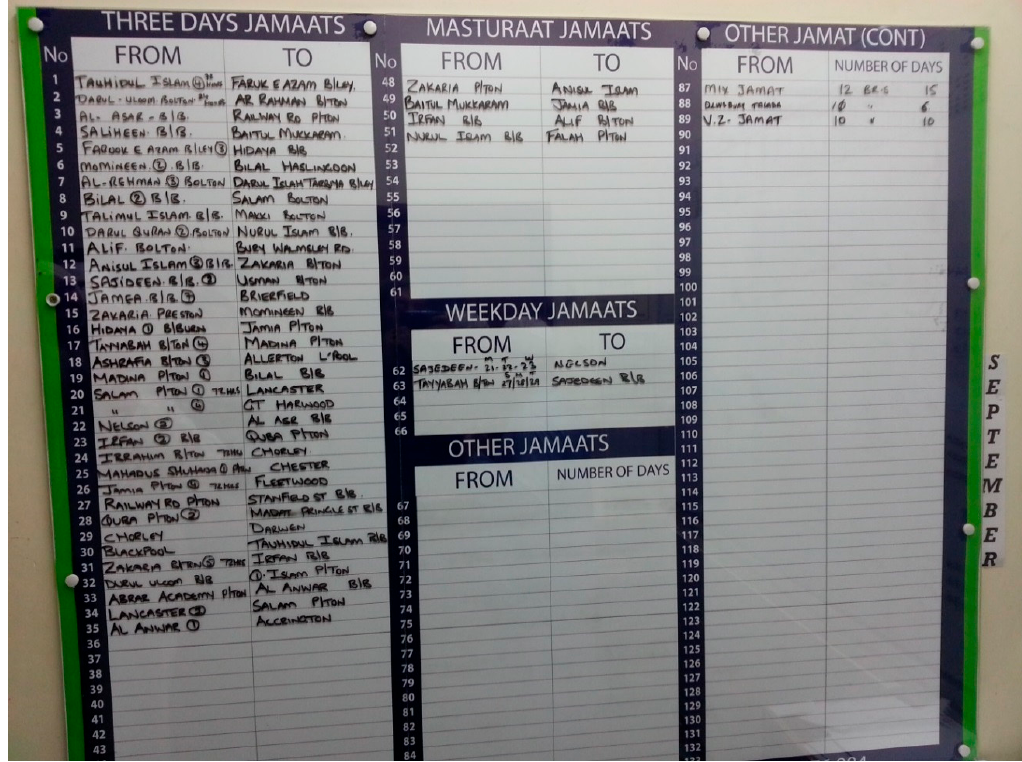
Figure 10. The oversized noticeboard template in Blackburn Markaz, freshly filled out on a Tuesday evening, that displays the “routes” of all the jama’at s operating in the Lancashire halqa on a typical week. Source: author’s photo (October 2013).